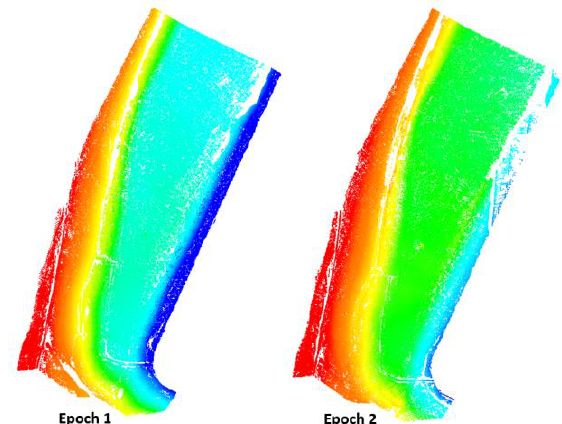
Figure 13. Both epoch 1 and epoch 2 mobile laser scanning data